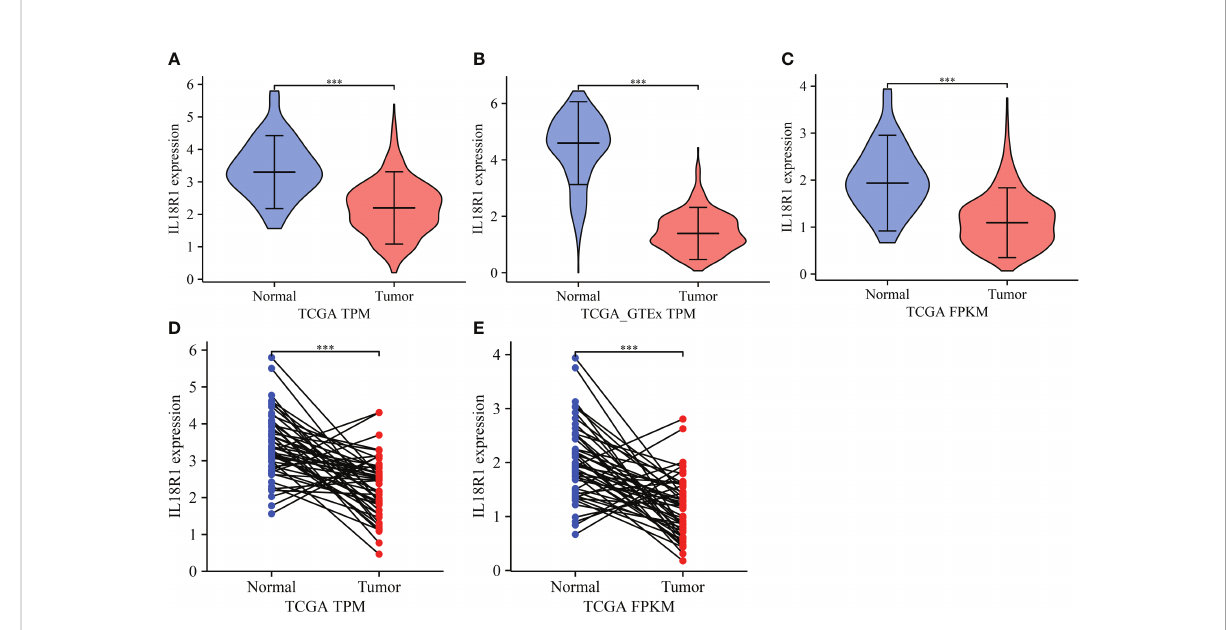
FIGURE 1 IL18R1 was signi fi cantly downregulated in the LUSC tissues based on the data of TPM and FPKM types in the TCGA and GTEx databases. (A – C) Unpaired tissues in LUSC; (D, E) Paired tissues in LUSC. LUSC, lung squamous cell carcinoma; TCGA, The Cancer Genome Atlas; GTEx, Genotype-Tissue Expression; ***P <